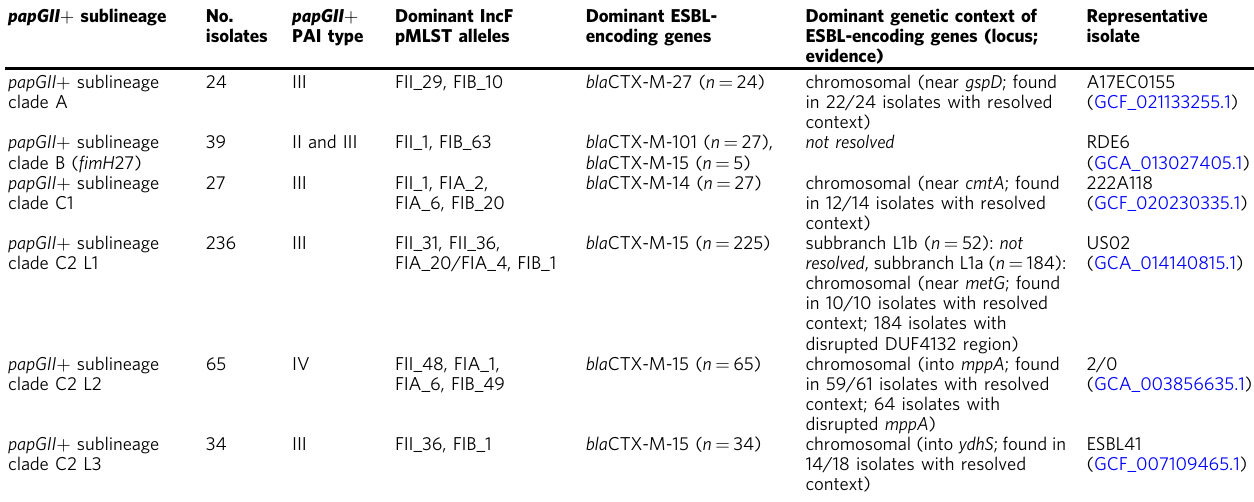
Table 3 Characteristics of dominant ST131 papGII -containing ( papGII + )